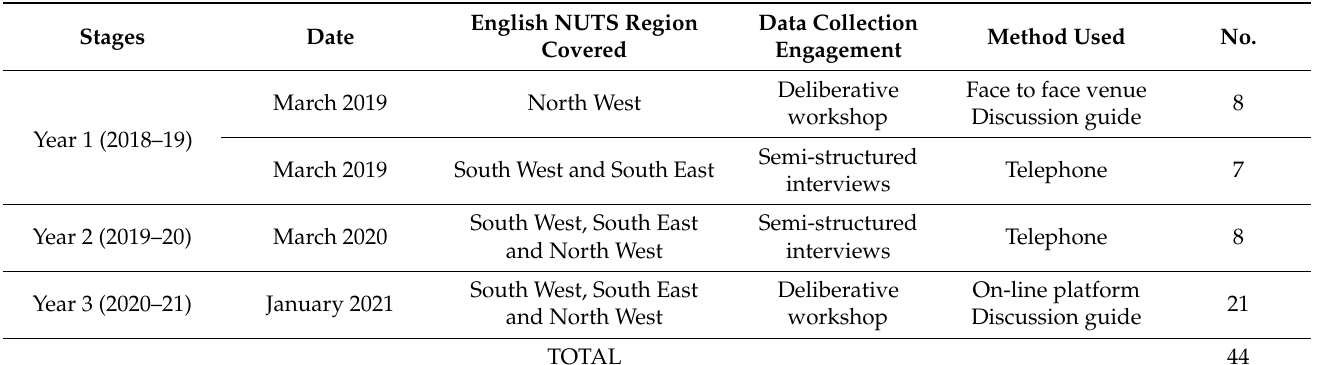
Table 1. Data sources and sample